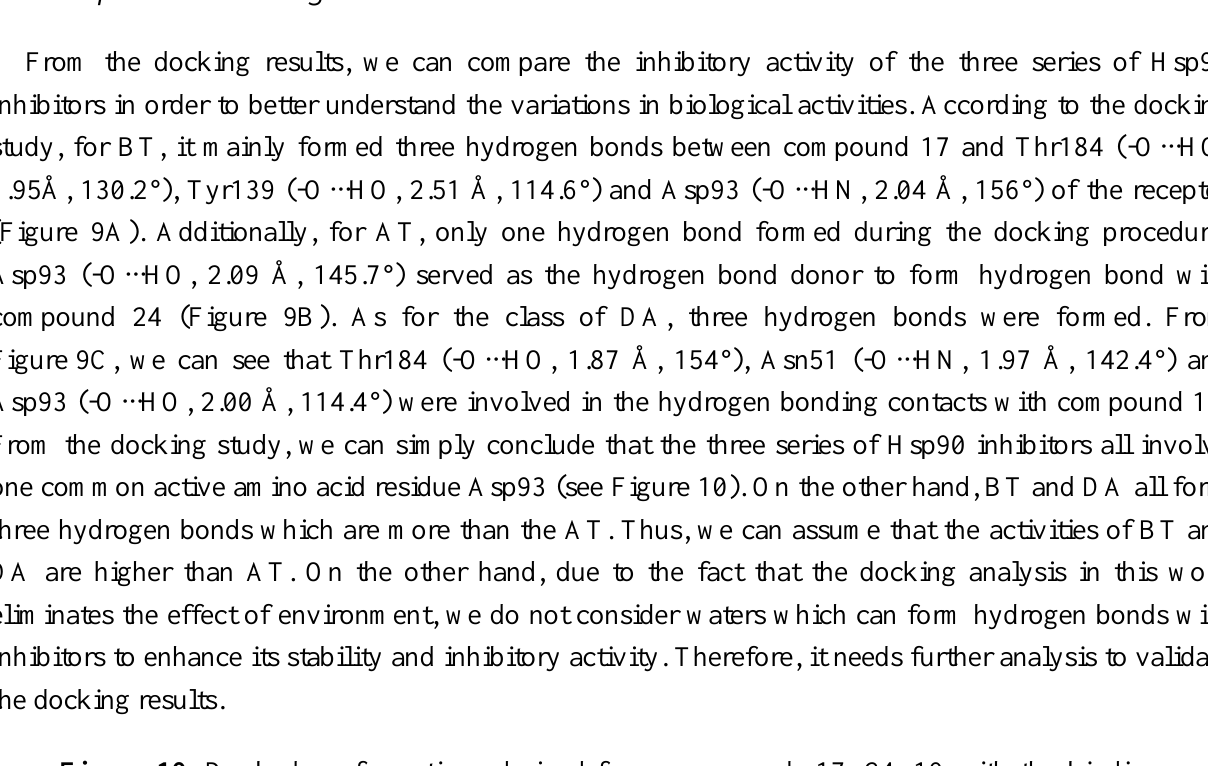
Figure 10. Docked conformations derived from compounds 17, 24, 19 with the binding site of Hsp90 protein; Hydrogen bonds are shown by broken lines; Compounds 17, 24, 19 are shown in A, B and C, respectively as a reference, and are depicted in different colors: cyan, blue and orange. Thr184, Asp93, Tyr139, Asn51, as the significant residues, are colored by atom type (C, yellow; N, blue; H, white; O,